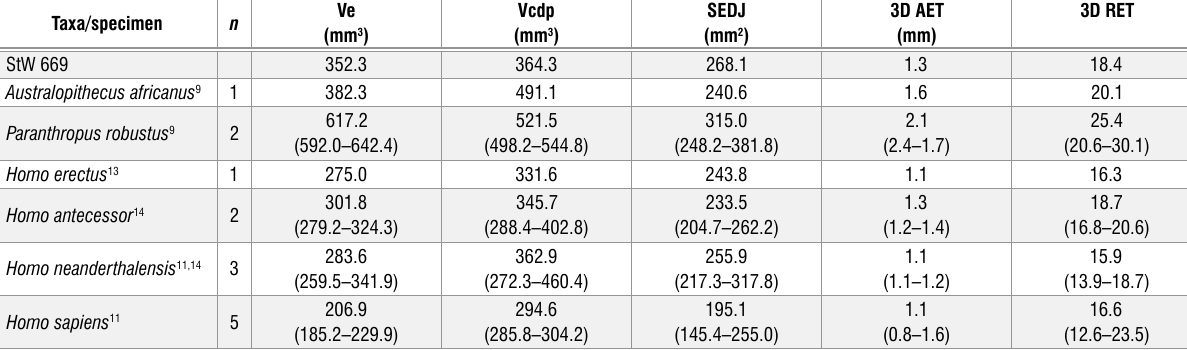
Figure 1: Original picture 2 (left) and virtual rendering of the enamel cap (light blue, middle) and of the enamel-dentine junction (light yellow, right) of StW 669. Three variables were measured in 3D and 2D 8,9,21 : volume (Ve, mm 3 ) and area (c, mm 2 ) of the enamel cap; volume (Vcdp, mm 3 ) and area (b, mm 2 ) of the coronal dentine that includes the coronal aspect of the pulp chamber; and surface (SEDJ, mm 2 ) and length (e, mm) of the enamel- dentine junction. We then calculated two indices of enamel thickness: 3D (3D AET, mm) and 2D (2D AET, mm) average enamel thickness, calculated 3D crown tissue proportions (including average and relative enamel thickness) of StW 669 and comparative fossil and extant hominins. For samples with more than one assigned specimen, mean as well as range (in parentheses) are given. Taxa/specimen